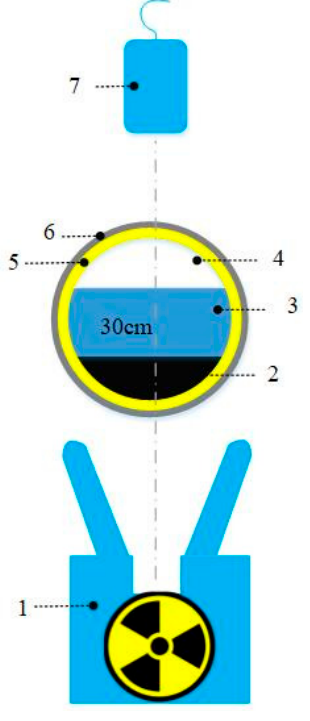
Figure 1. Structure simulated with MCNP code: (1) dual - energy gamma source, (2) oil, (3) water, (4) gas, (5) scale, (6) steel tube, and (7) sodium iodide detector.